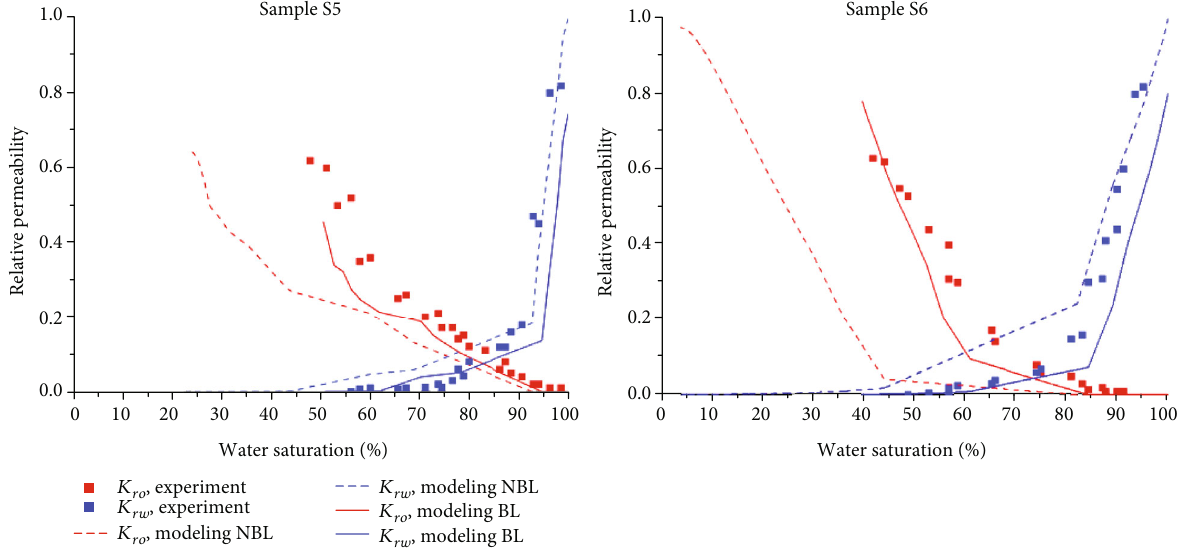
Figure 4: Predicted relative permeability of S5 and S6 tight sandstone (lines) compared to the experimental results (square). The oil relative permeability data are marked with red, while the water relative permeability data are marked with blue. Data modeling NBL/BL means that the calculations using the model without/with BL consideration,